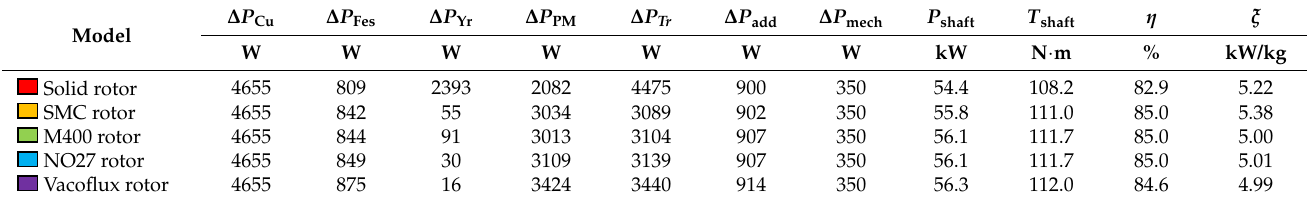
Table 2. Basic properties of the analyzed materials in the rotor yoke. Table 4. FEM analysis results for the rated rotational speed n = 4800 rpm ( f = 800 Hz) and the current density in the winding J = 30 A/mm 2 . Model